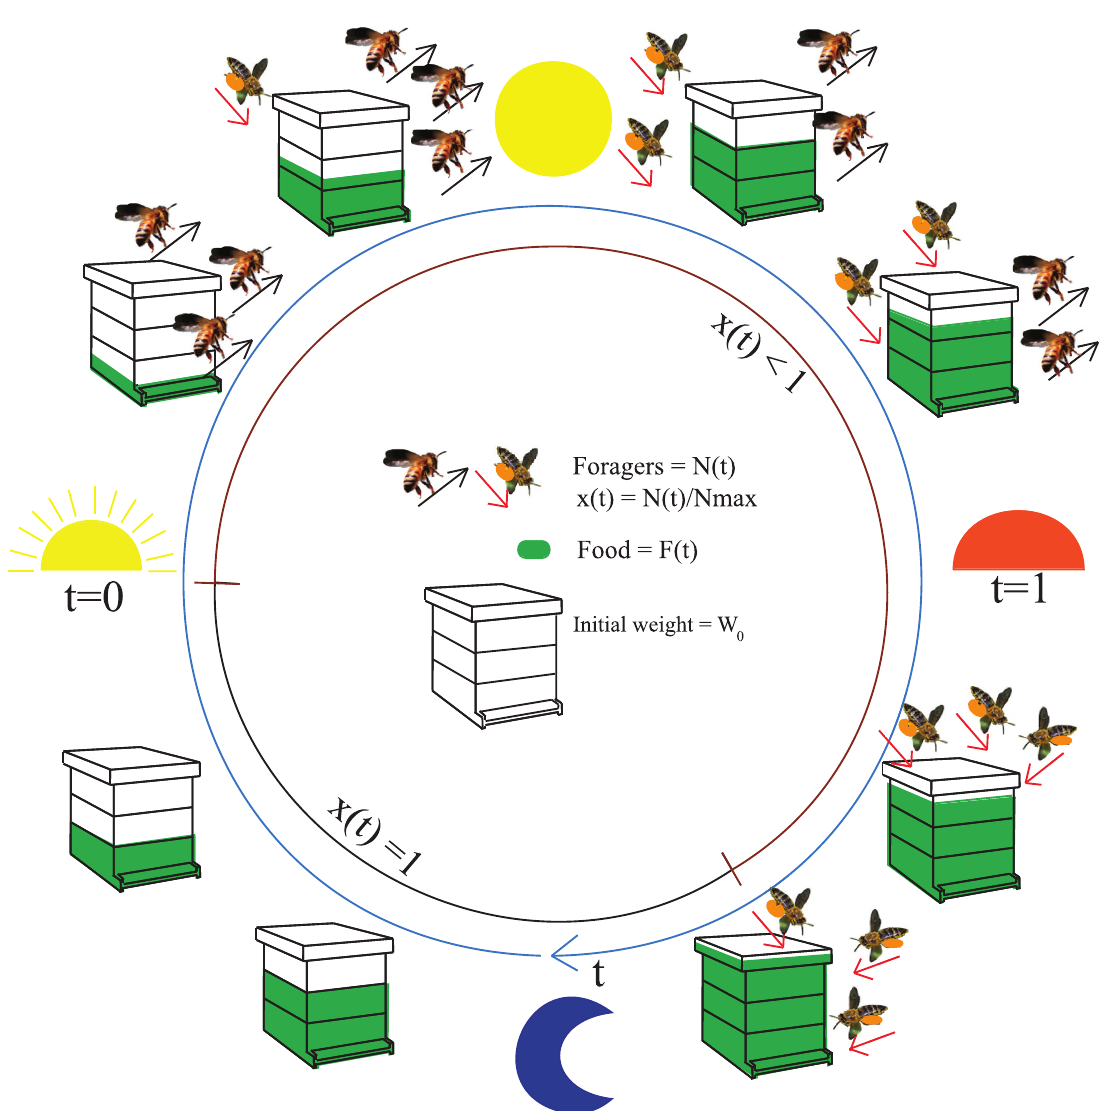
Fig 2. Schematic representation of the daily cycle of bee activities relevant to modeling colony weight, where time flows in a clockwise direction (blue line). The main time-dependent elements we model are the number of forager bees N ( t ) and the food F ( t ) (in green) inside the hive. The foragers are represented as active bees that depart the hive (black arrow) and return to it (red arrow) with food (in orange). The ratio of forager bees inside the hive at a particular time is represented by x ( t ), which is constant before and after the dynamics of forager bees because the N foragers are all inside the hive. The static weight W 0 is composed of the hive structure and bees max that do not leave the